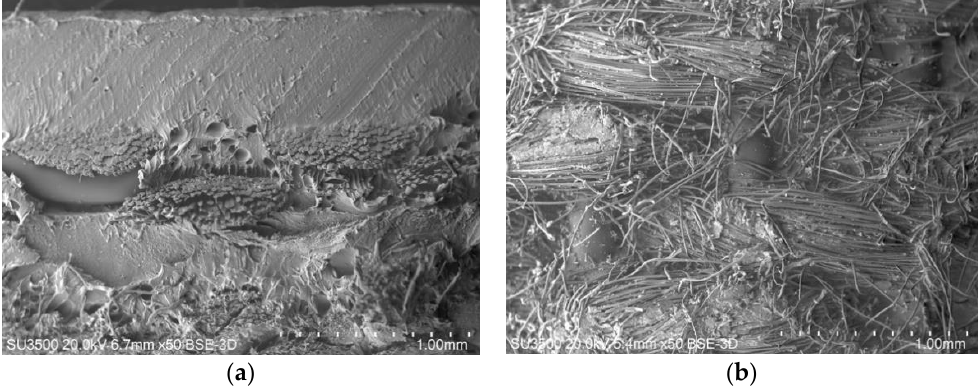
Figure 9. SEM images of: ( a ) cross-section, ( b ) bottom side of material samples for KKA 30-20 test variant.